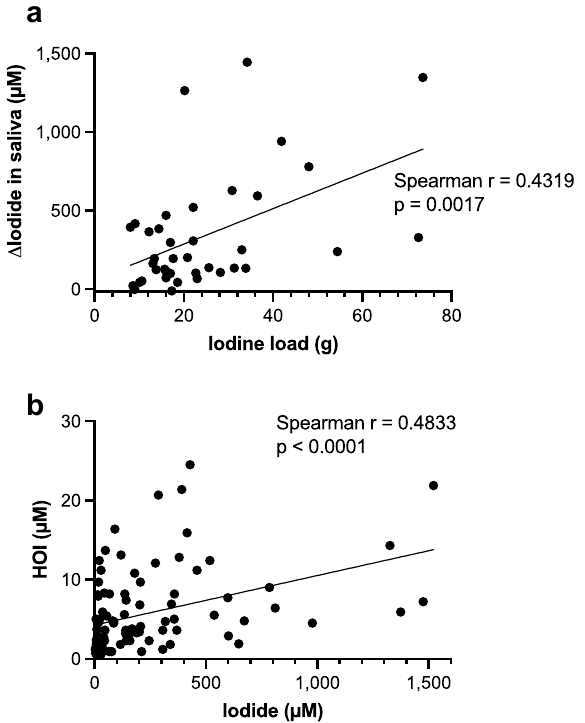
Figure 3. Correlations between iodine load, and salivary iodide and HOI levels. ( a ) Paired iodine content in the injected contrast medium (iodine load) and the changes in iodide levels (Δiodide) in saliva from all data of baseline and 6 h after the injection were plotted (n = 39 pairs). Correlation between the iodine load and Δiodide in saliva was analyzed by the Spearman correlation test and r value, with a simple linear regression fitted line and p value added to the graph. ( b ) Paired iodide and HOI values in saliva from all data were plotted (n = 96 pairs). Correlation between iodide and HOI levels was analyzed by the Spearman correlation test and r value, with a simple linear regression fitted line and p value added to the